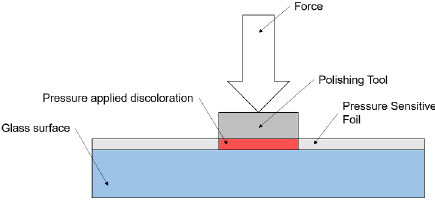
Figure 1. Experimental setup for the case of a plane glass sur- face: Under the in fl uence of a force, a pressure occurs in the con- tact area between the polishing pad, pressure measurement fi lm and glass surface. Under this pressure the pressure measuring fi lm changes colour.